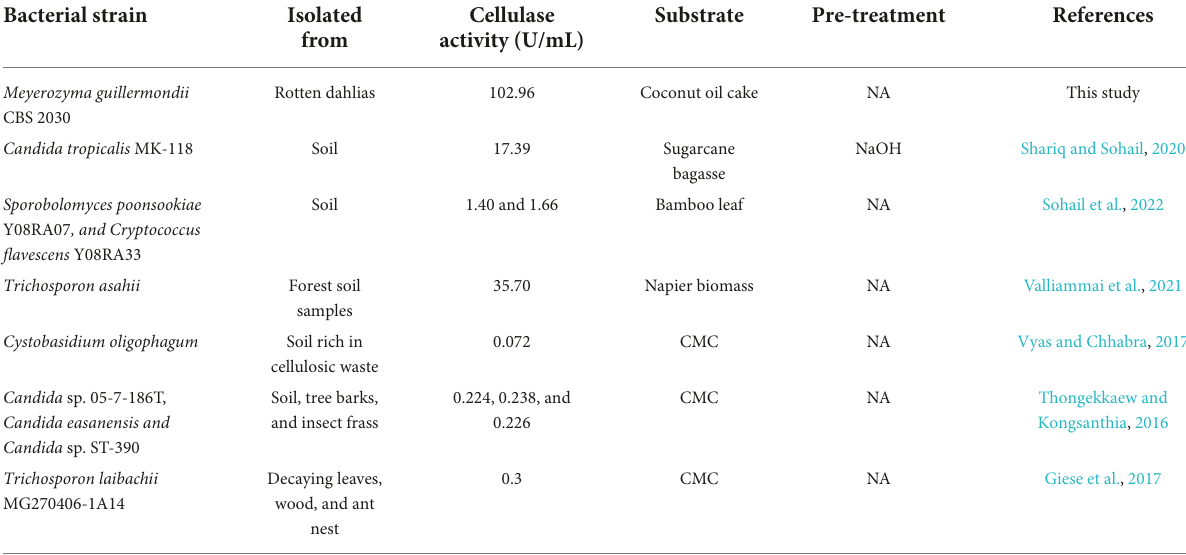
TABLE 1 Comparison between the largest cellulase produced by M. guillermondii CBS 2030 and early discovery. Bacterial strain Isolated Cellulase Substrate from activity (U/mL)